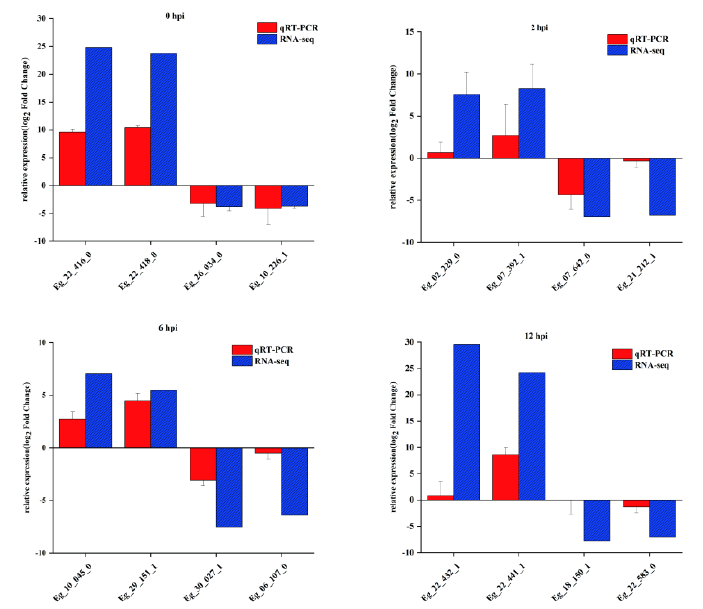
Figure 3. Validation of the differentially expressed genes between larvae feeding on EcobNPV-QV- and EcobNPV-QF4-infected leaf using qRT-PCR. The GAPDH gene was used as a control, to normalize the gene expression of EcobNPV-QV vs EcobNPV-QF4 with qRT-PCR. All data represent mean ± SEM ( n = 3).